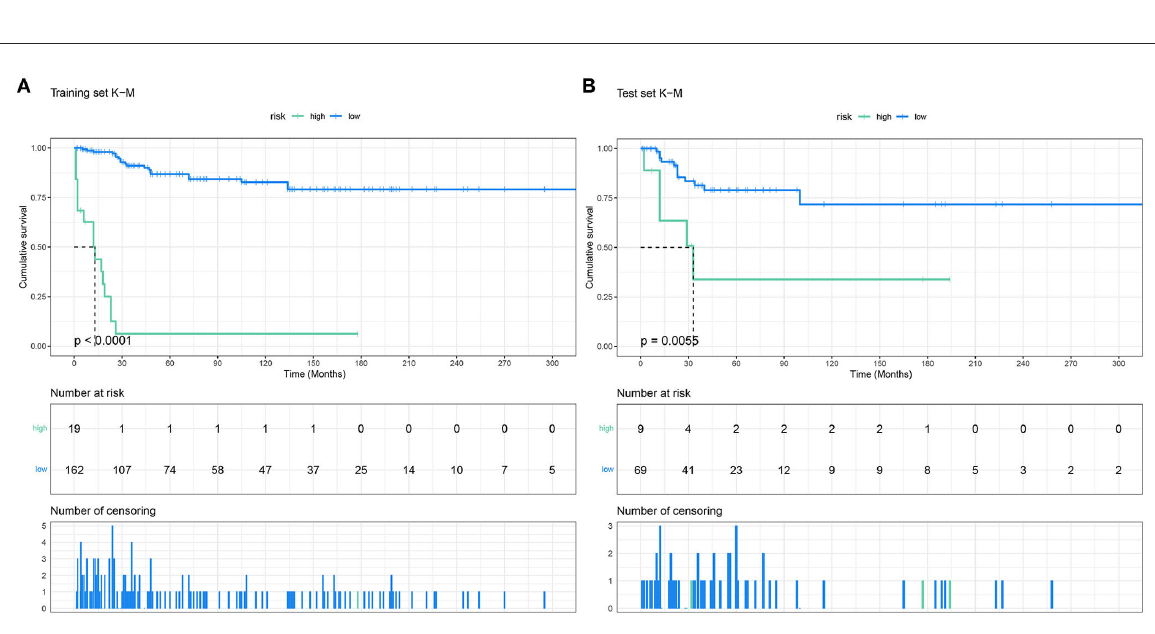
FIGURE6 The Kaplan–Meier survival curves of the patients in the training set (A) and in the validation set (B)